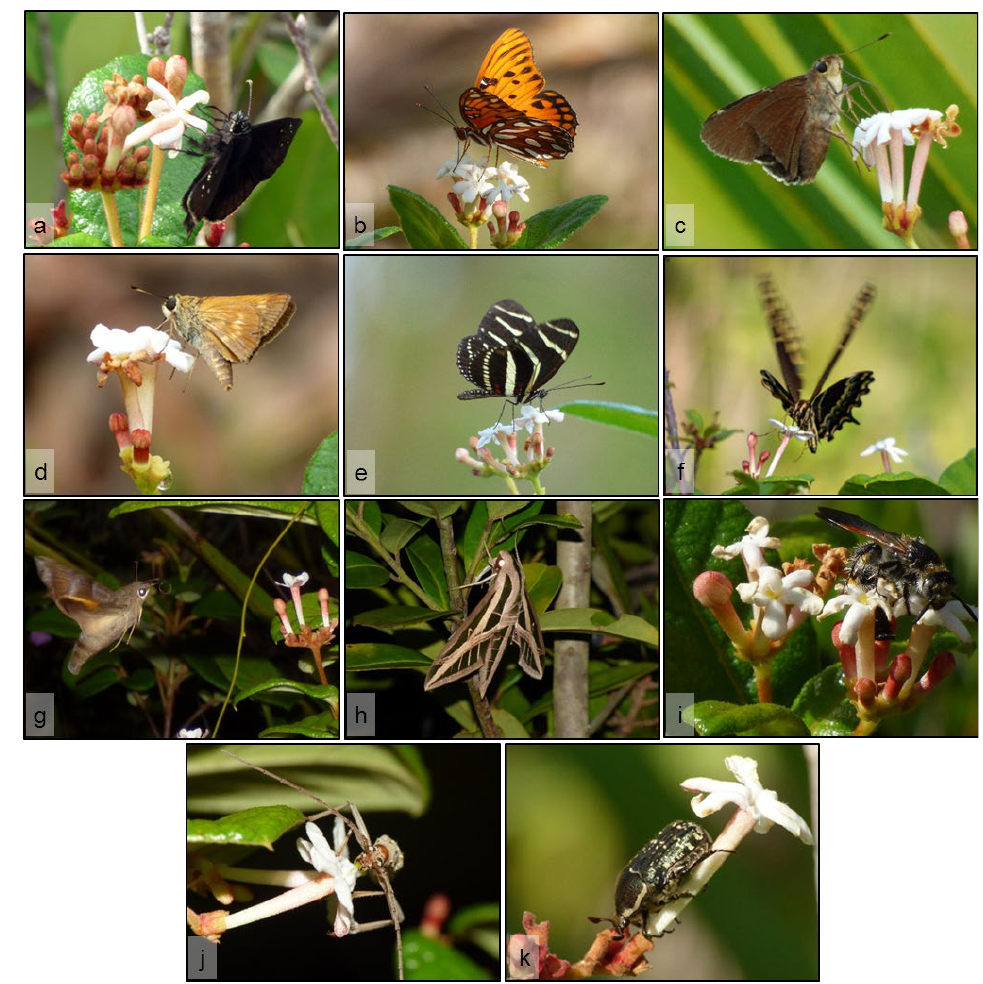
Figure 4. Overview of some species of flower visitors performing legitimate visitation and behaving as potential pollinators of Guettarda scabra at two pine rockland sites (Larry and Penny Thompson Memorial Park, LPT; and Long Pine Key, Everglades National Park, ENP) in south Florida, USA. Some lepidopterans such as ( a ) Ephyriades brunnea , ( b ) Agraulis vanillae , and ( c ) Asbolis capucinus were observed in both study sites, while ( d ) Polites baracoa and ( e ) Heliconius charithonia were seen only in LPT. Other visitors were only seen in ENP, such as ( f ) Papilio palamedes that feeds on nectar during daytime, and the nocturnal hawkmoths ( g ) Perigonia lusca and ( h ) Eumorpha fasciatus , represented here by an individual resting after a feeding bout. Besides lepidopterans, ( i ) the wasp Dielis trifasciata is seen here coming in close contact with the exposed stigma of a flower as it feeds on pollen during the morning. Beetles such as ( j ) Eburia stigma and ( k ) Euphoria sepulcralis visited flowers to feed on pollen and stigma exudates.